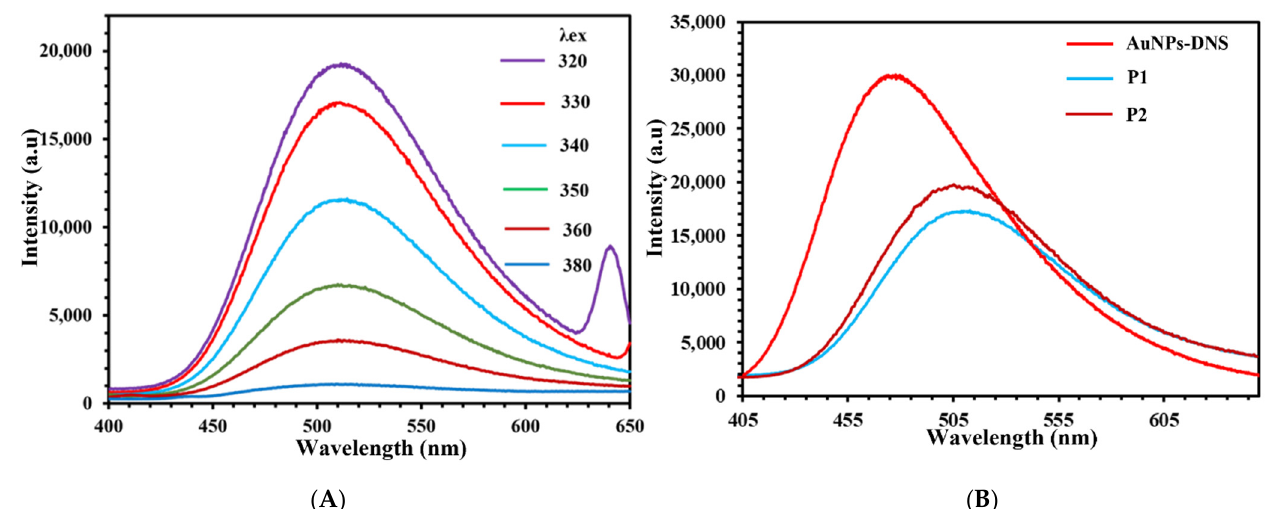
Figure 6. Fluorescence emission spectra of ( A ) AuNPs ‐ DNS + ssDNA (P1) at different excitation wavelengths, ( B ) peak shifts for AuNPs ‐ DNS upon P1 and P2 immobilization.